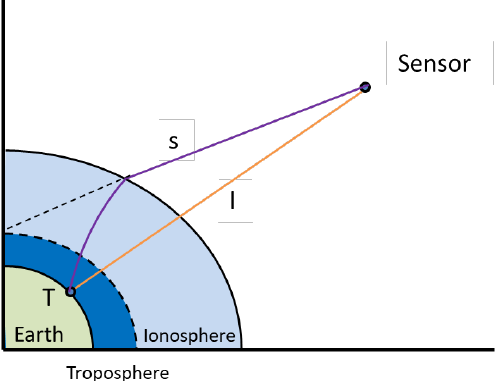
Figure 1. The propagation path of the signal in the atmosphere (disproportional schematic